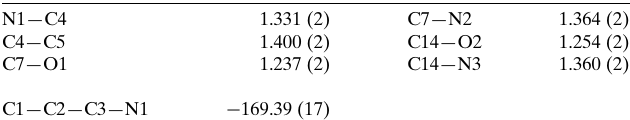
Table 3 Dihedral angles ( (cid:3) ) between selected planes in ( I ) and ( II